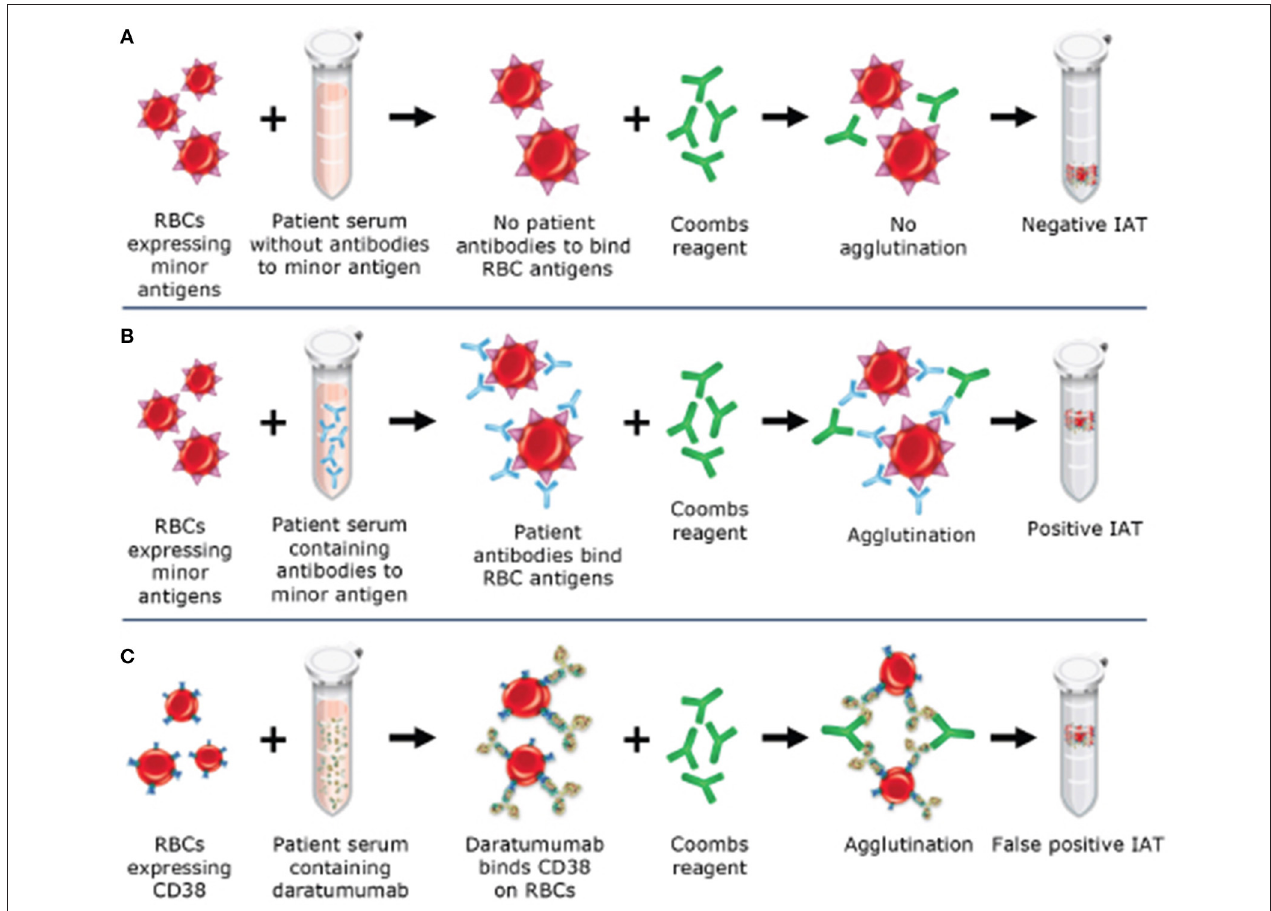
FIGURE 1 | Mechanism of daratumumab interference with the indirect antiglobulin test (IAT). (A) Negative IAT in a sample without RBC alloantibodies or daratumumab. (B) Positive IAT due to RBC alloantibodies in the sample. (C) Positive IAT due to interference from daratumumab, which binds to CD38 on RBCs and causes agglutination with the addition of Coombs